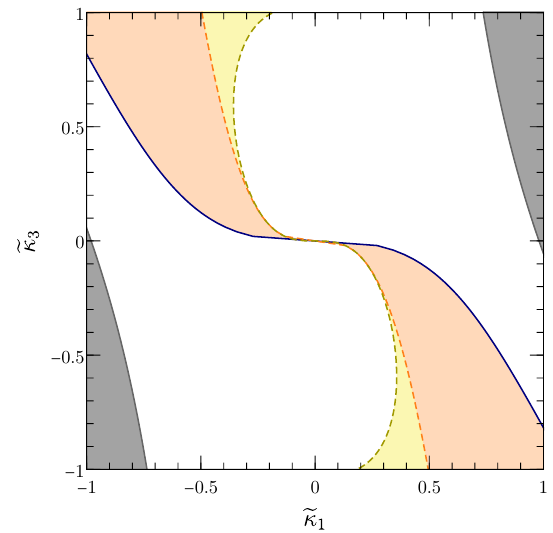
Figure 9 . Regions of parameter space where the scalar (cid:12)eld (cid:30) settles directly in the true vacuum (in white), settles in the false vacuum after in(cid:13)ation before possibly thermally decaying (in orange), and where the thermal potential V ( (cid:30); T ) incurs a two-stage rolling, (cid:12)rst into the false then into the true vacuum, after in(cid:13)ation (in yellow) for y = 0 : 8. The region shaded in grey corresponds to a e single minimum potential. The orange region is calculated using the condition given in section 3.2, whereas the yellow corresponds to the region where eq. (B.3) has three real positive solutions for e T . The boundary of the yellow region corresponds to the line e T 0 = e T c , where e T c is the temperature given by eq. (3.6) where the two minima are degenerate, and corresponds to the boundary of the region where the scalar (cid:12)eld can roll into the false vacuum after in(cid:13)ation. The e(cid:11)ects of vacuum decay are not included in this (cid:12)gure.